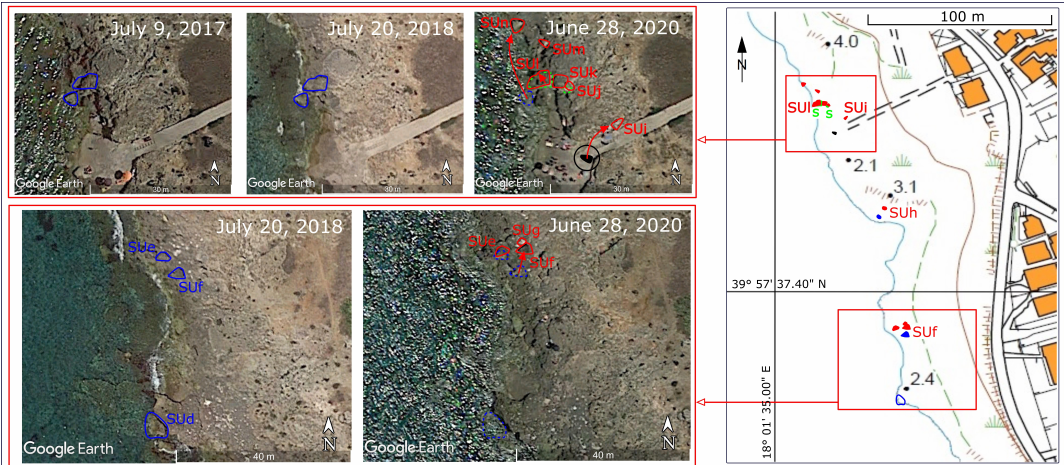
Figure 7. Comparative satellite images of Torre Suda. The initial positions of the boulders are highlighted in blue, the final ones in red, and the sockets are green. Red arrows highlight the displacements. In the June 2020 image, the boulder SUi as transported by the October 2018 storm is reported (in dark). Topography from the technical map of Lecce Province (1:5000).